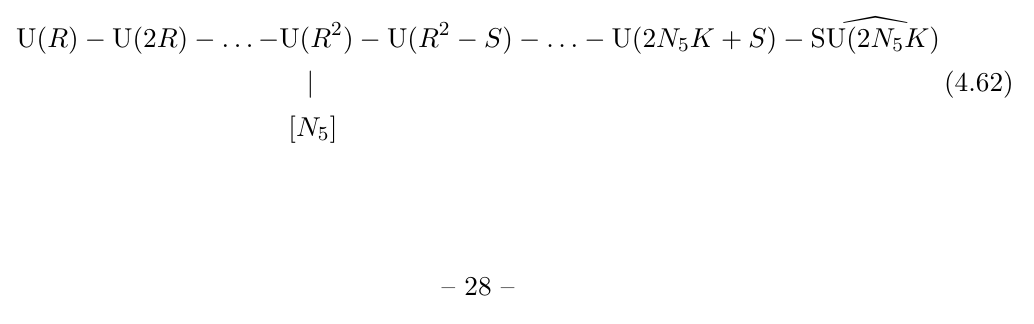
Along the first ellipsis the rank increases in steps of N , along the second ellipsis the rank is constant, and along the third the rank decreases in steps of N . The charges carved out by the D5 0 branes are shown in figure 7. They again reproduce the quiver